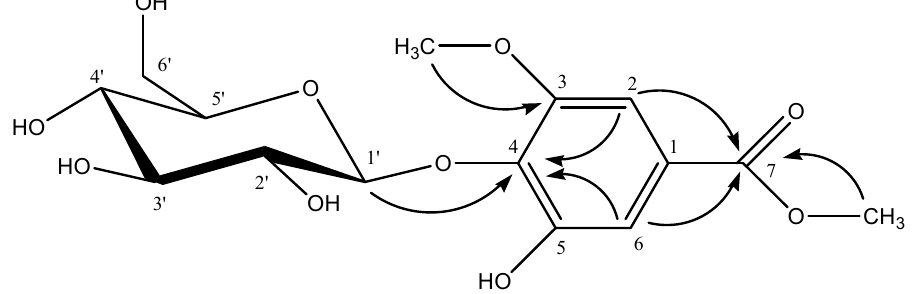
Figure 1. The key HMBC correlations of methyl 4- O - β - D -glucopyranosy-5-hydroxy-3-methoxylbenzoate.